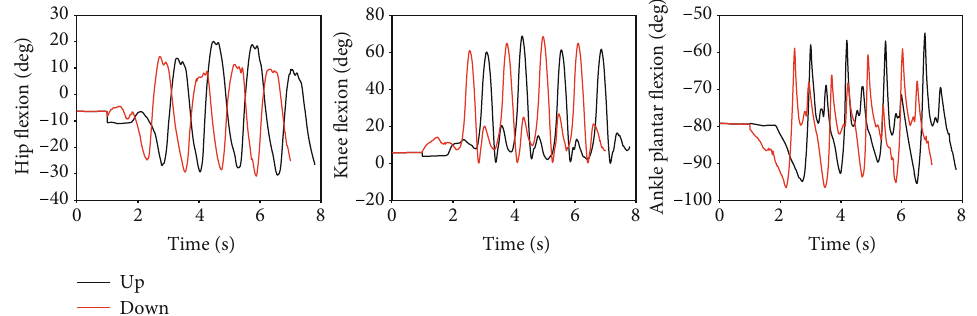
Figure 9: Joint angles during walking up the ramp (trial 9) and down the ramp (trial 10). These results are taken from subject Next, we compare the spatiotemporal gait parameters Figure 13 shows the joint angles and torques (mean and between the participants with intact limbs and the transfemoral standard deviation) for the right leg (prosthesis side) of a prosthesis users at di ff erent walking speeds. A scatter plot com- transfemoral prosthesis user (PR01), trial 3, over a total of bined with a box plot is used to visualize the gait parameters in 30 strides. The data are from walking at their preferred speed Figures 16 – 18. Although the gait speed of each subject is di ff er- of 0.8 m/s. Moreover, Figure 14 shows the vertical GRF ent, scatter plots show the average of the gait parameters for (mean and standard deviation) for the same trial. Figure 15 each individual trial for each subject, while the box plots show shows the joint angles during the transition from slow walk- the ranges of the parameters. The results are distinguishable ing (0.6 m/s) to fast walking (1.1 m/s), and vice versa, for based on the gait speed of each subject. The gait parameters prosthesis user PRO2. These data are shown in the fi gure include stride frequency, stride length, and stride width. for trials 21 and 23, respectively.